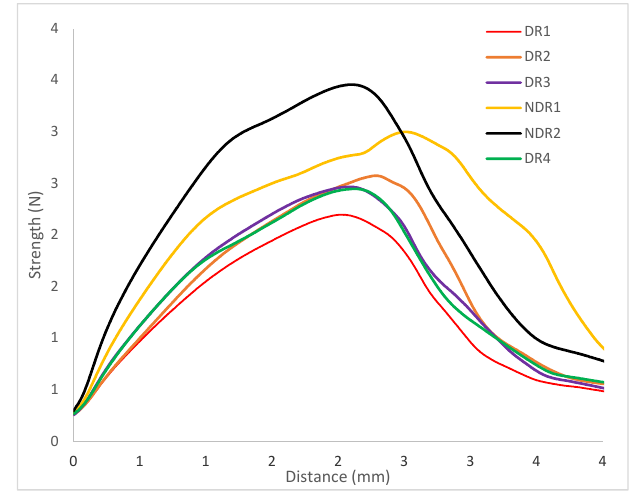
Figure 10. Load-deflection profiles of filament samples in tensile tests. Table 11. Summary of texturometer analysis.